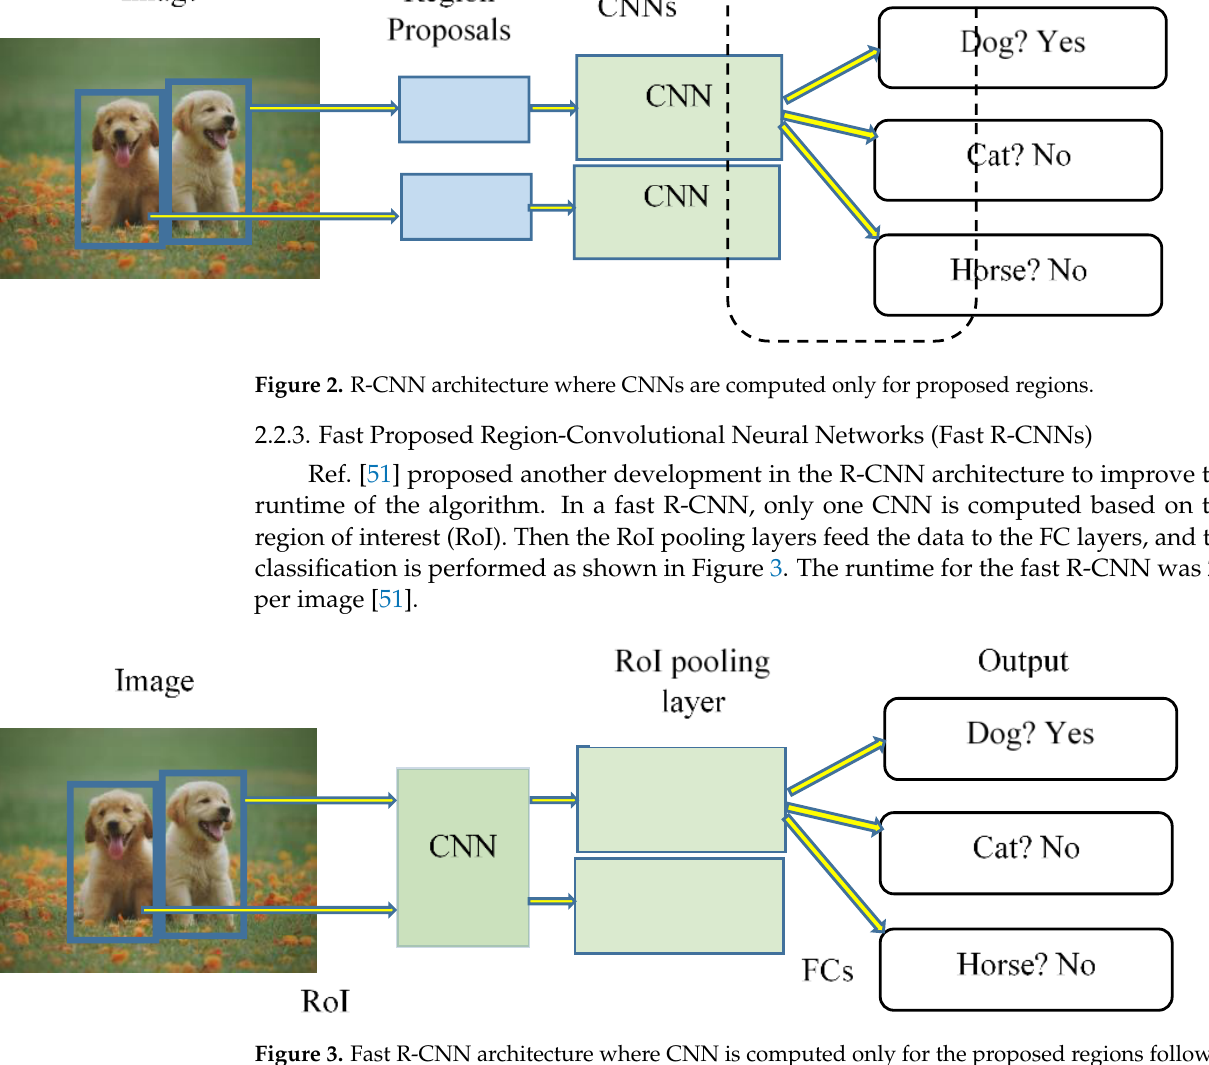
Figure 1. CNN architecture showing convolution layers and fully connected layers for image classification.